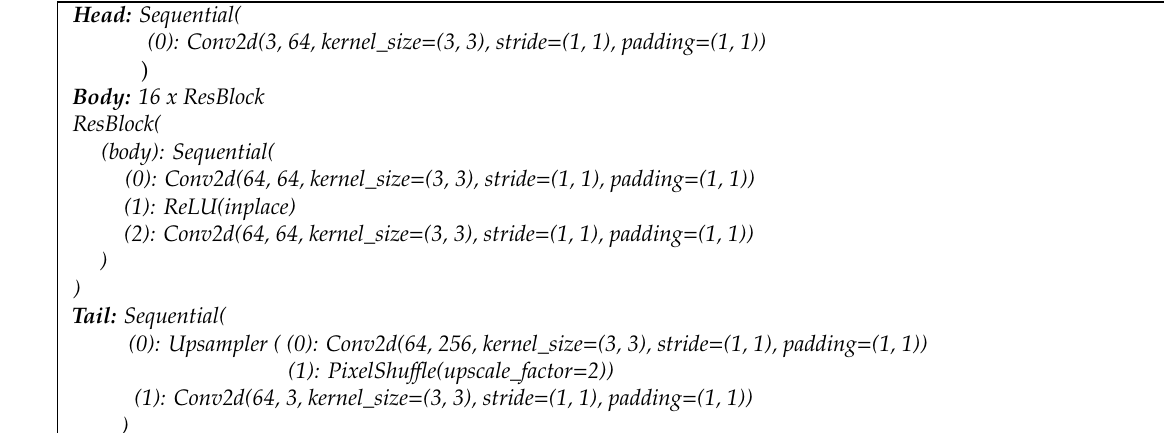
Table 1. Components of the single-scale baseline EDSR architecture.